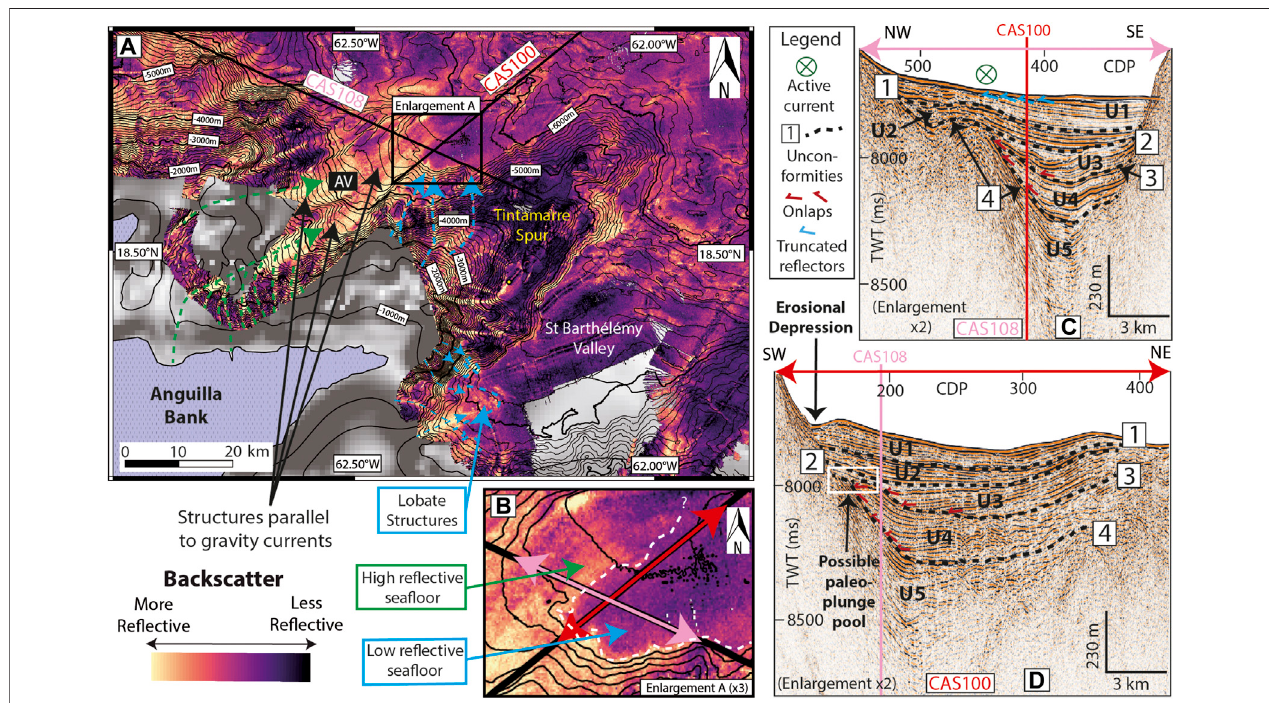
FIGURE10| Enlargementofthetwomainvalleys. (A) Interpretedbackscattermap.BluedashedarrowsrepresentsedimenttransferfromthenortheasternAnguilla Bank.BluedotsdelimitlobatestructuresintheSt-BarthélémyValley.Greendashedarrowsrepresentsedimenttransferfromthepaleo-platformsoftheTintamarreSpur. AV: Anguilla Valley. Please note that the backscatter pattern is totally different between the two valleys. (B) Enlargement of Figure 10A . The light pink double arrow locates the enlargement C coming from the seismic line CAS108 ( Figure 7A ). The red double arrow locates the enlargement D coming from the seismic line CAS100.Thewhitedotsseparatetheactivetransferarea(indicatedbyagreenarrow)andthetransferanddepositionarea(indicatedbyabluearrow). (C) Enlargementof the seismic line CAS108 ( Figure 7A ). The red line indicates where the seismic line CAS100 cut the seismic line CAS108. The vertical exaggeration is x5 for the seismic pro fi le. (D) EnlargementoftheseismiclineCAS100.U1toU5referstothenumberofunits.ThelightpinklineindicateswheretheseismiclineCAS108cuttheseismicline CAS100. The vertical exaggeration is x5 for the seismic pro fi le.